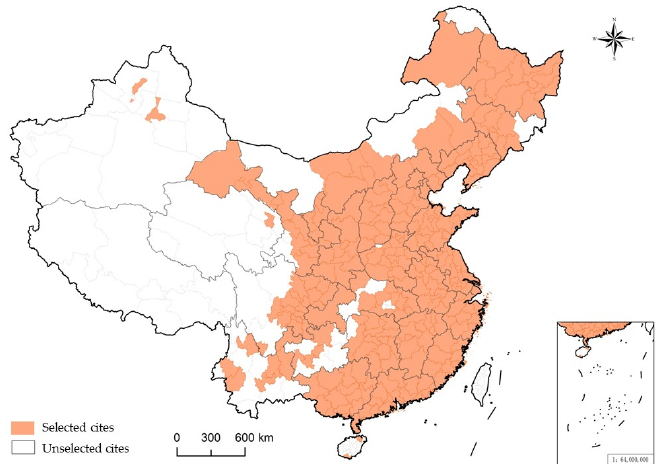
Figure 3. The spatial distribution of the 282 cities in China.